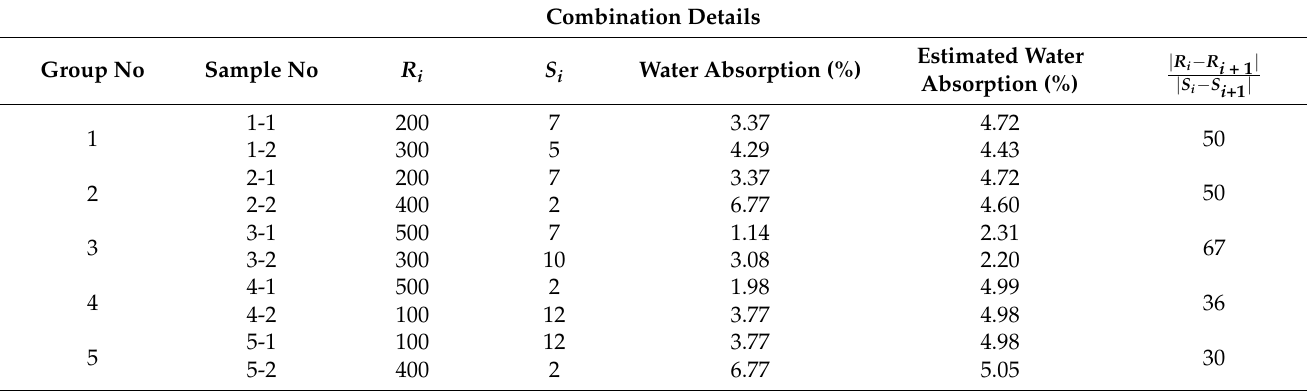
Table 6. Exemplary combinations and estimated water absorption values for 11.2–22.4 mm